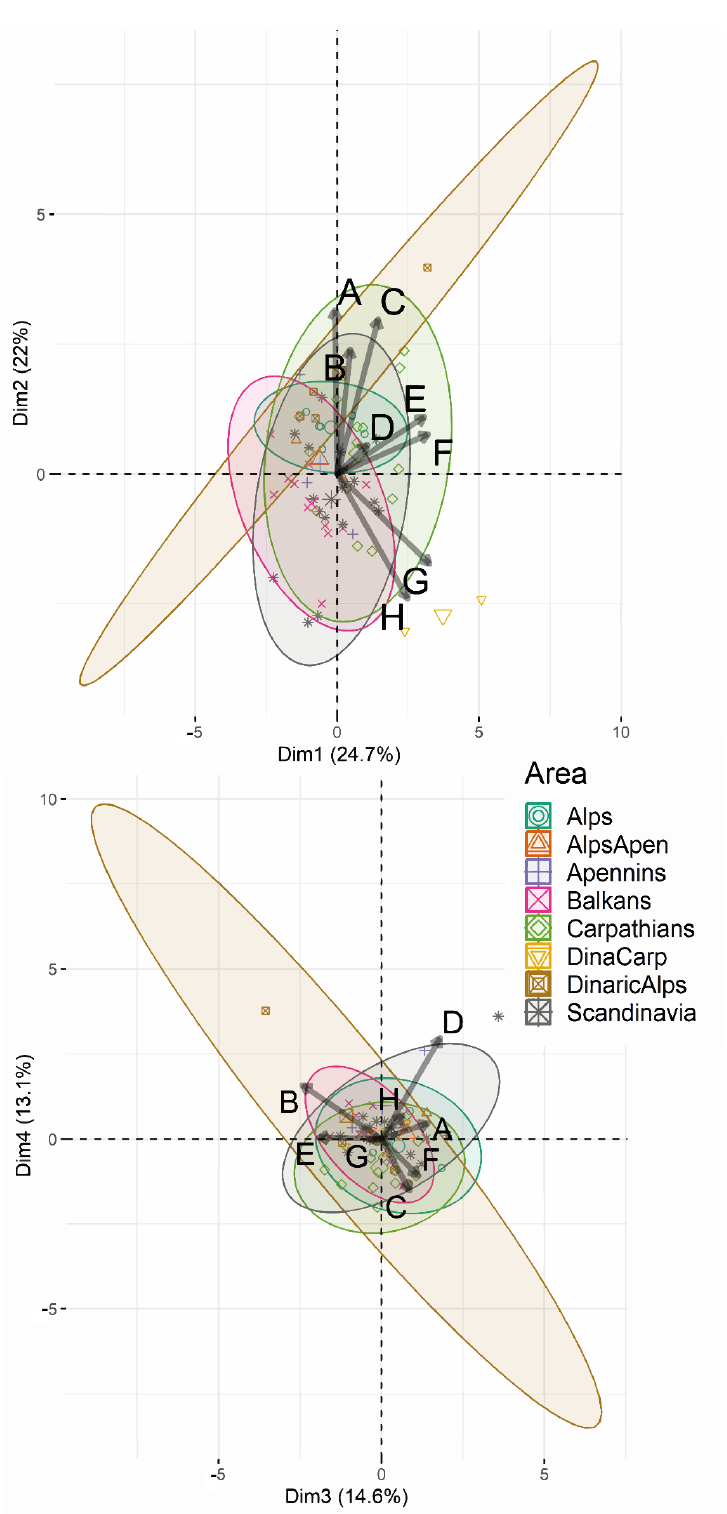
Figure 5. Biplot of variables and individuals classed by study areas (PSD – PCA).